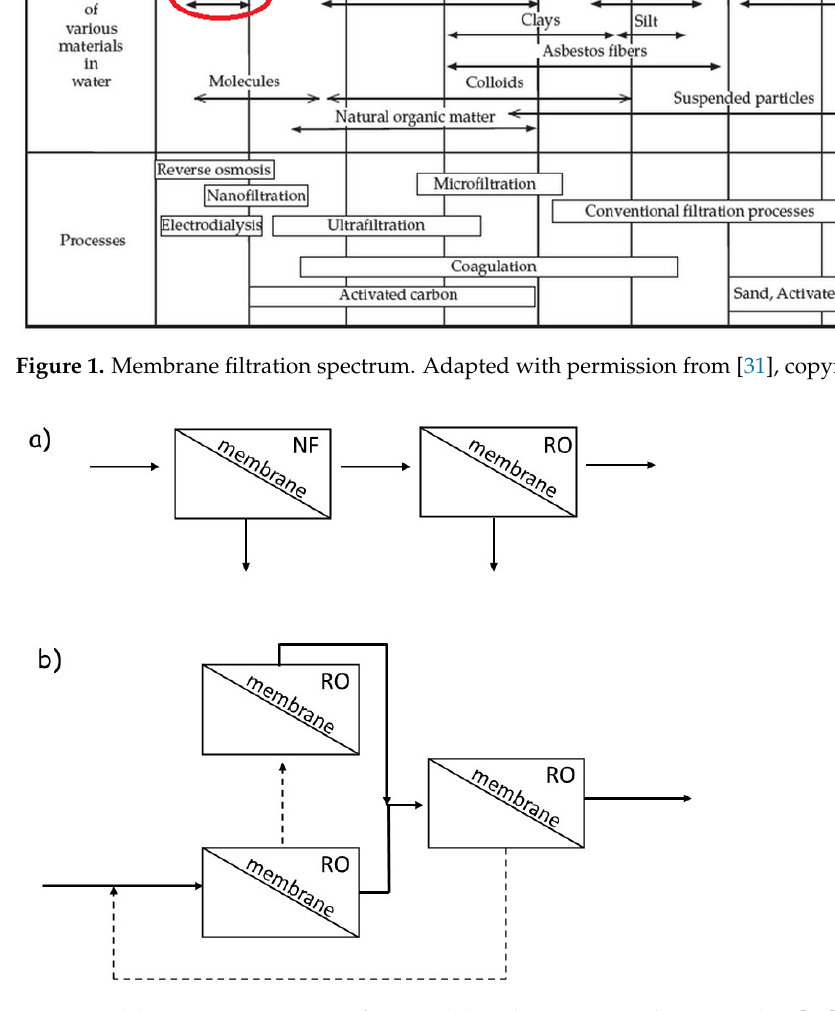
Figure 2. ( a ) NF as pretreatment for RO; ( b ) multistage RO scheme used in [37]. Adapted with permission from [37], copyright of